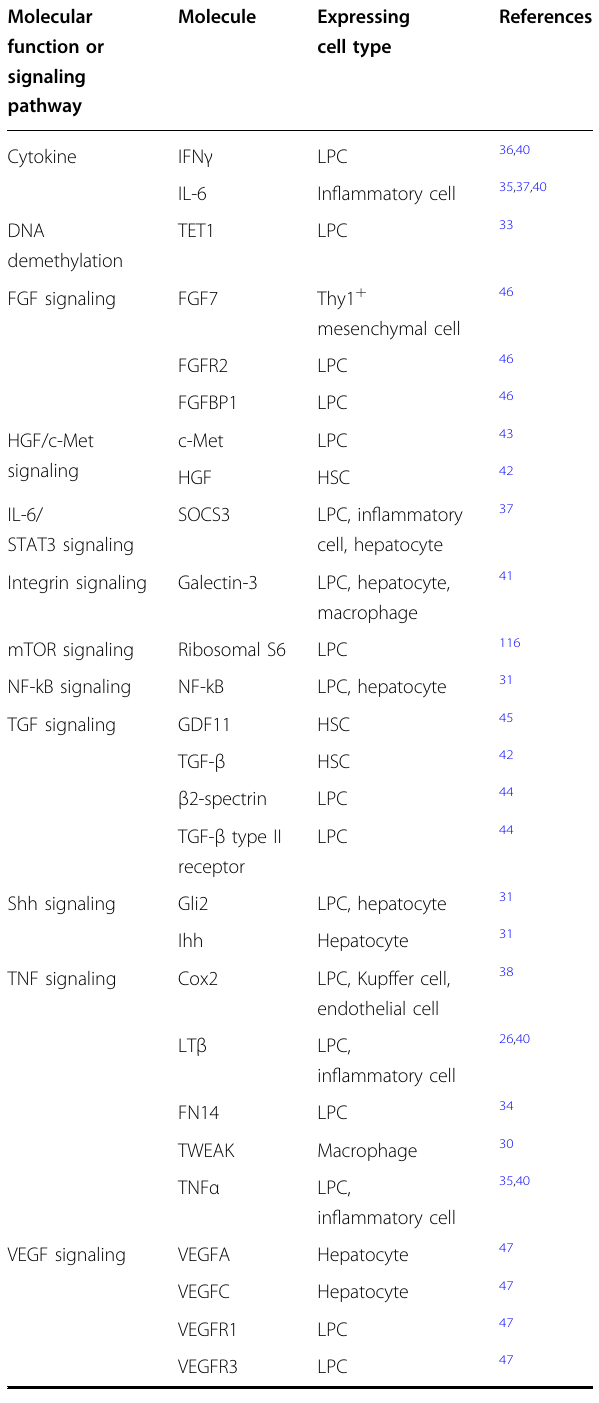
Table 1 List of molecules involved in LPC activation and their expressing cell types.